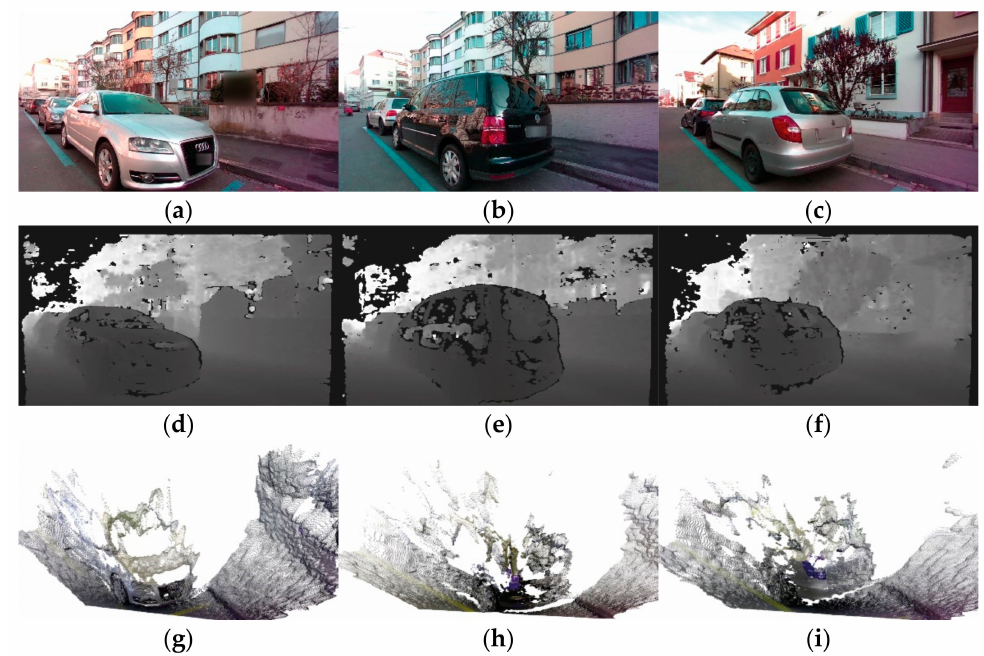
Figure 3. Three different parked cars: ( a – c ) show the RGB images, ( d – f ) depict the associated depth maps, and ( g – i ) represent the processed point clouds. The point clouds were colored in this visualization for better understanding of the scene. However, the data pre-processing does not include coloring of the point